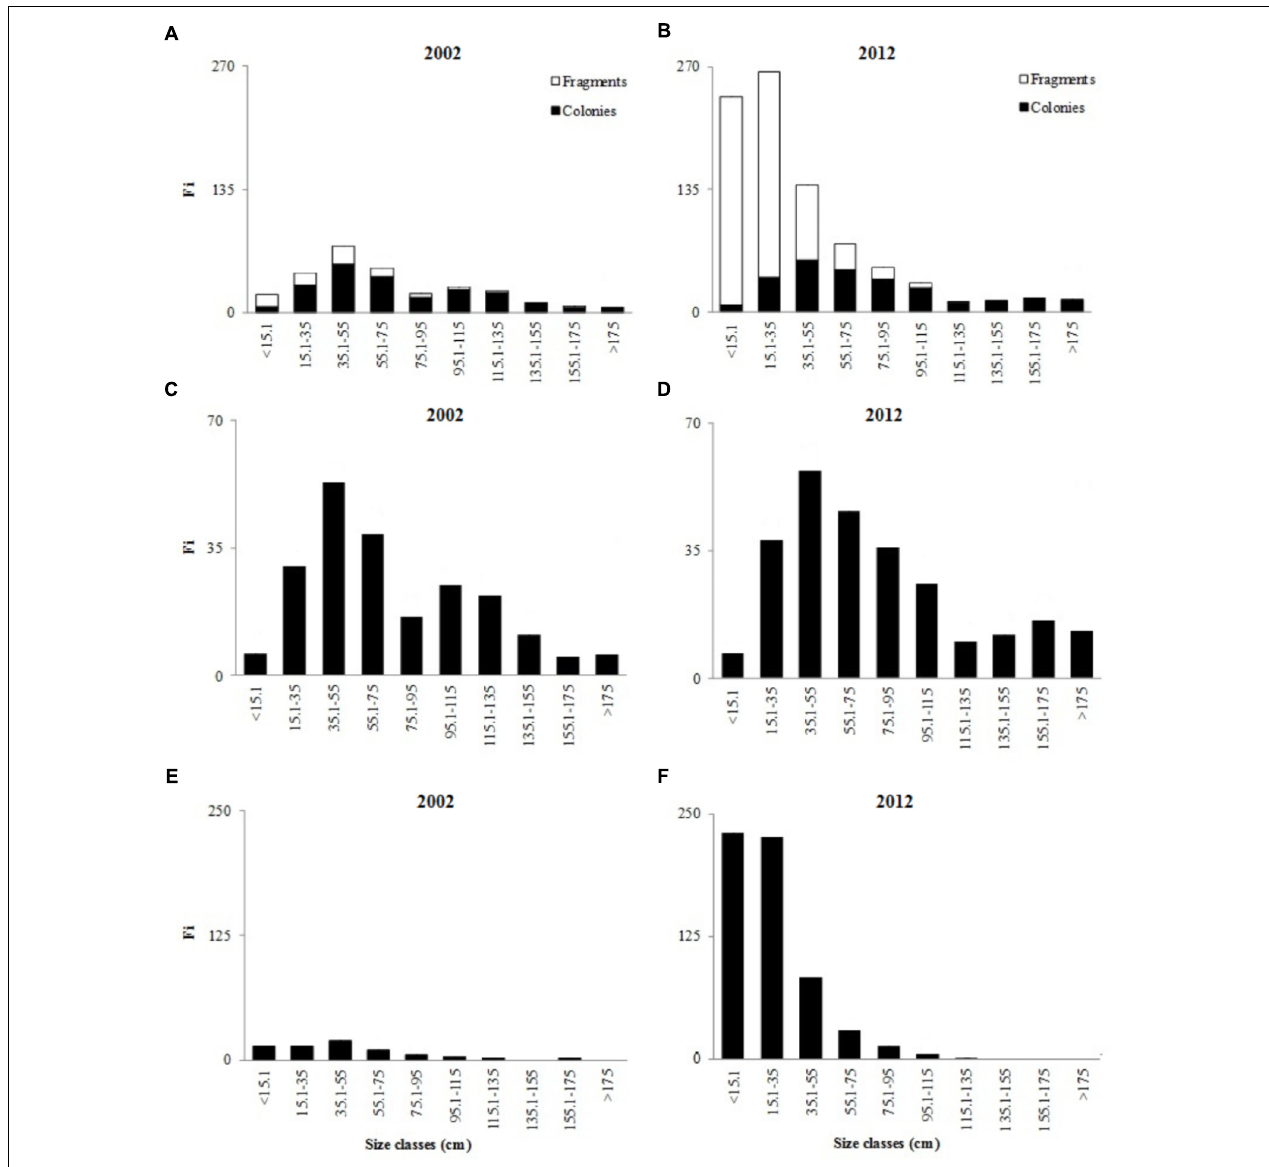
FIGURE 2 | Dendrogyra cylindrus population structure in terms of the frequency of colonies and/or fragments per size class. Total population (including colonies and fragments) in 2002 and 2012 (A,B) . Colony contribution per size class in 2002 and 2012 (C,D) . Relative contribution of fragments to the size classes in 2002 and 2012 (E,F) . Fi: absolute